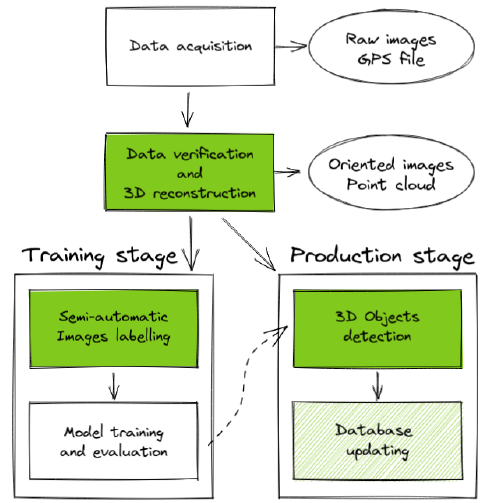
Figure 2: Processing chain that was developed. In plain green are the automated steps and in hashed green are the steps that remain to be completed. Rectangles indicate processes and ellipses the data.